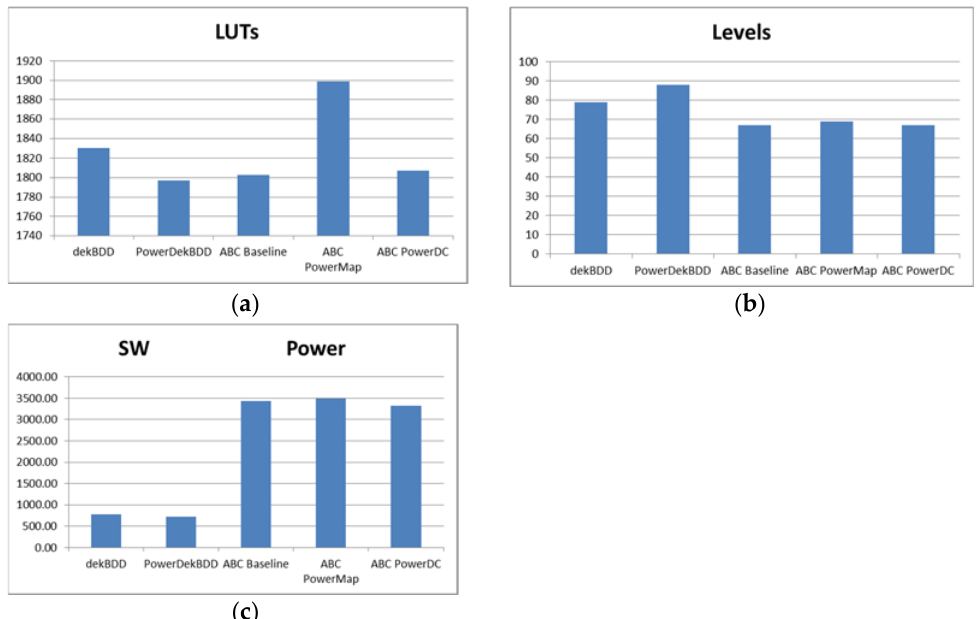
Figure 6. Comparison of academic systems in terms of: ( a ) the number of LUTs; ( b ) the number of logic levels; ( c ) switching activity (Power).